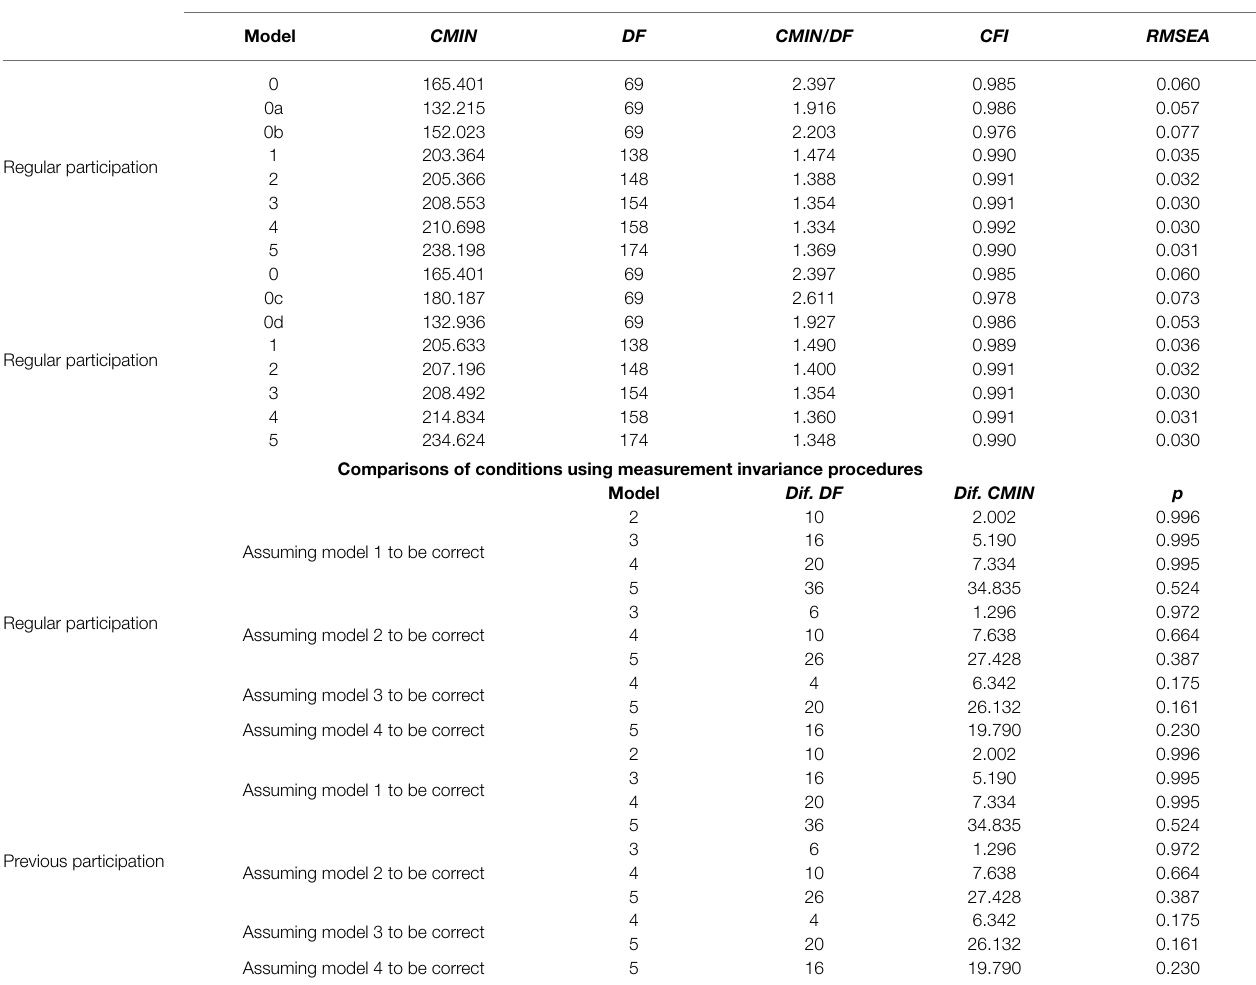
TABLE 4 | Adjustment statistics for the models. Variable Goodness-of-fit indices and model comparisons for tested